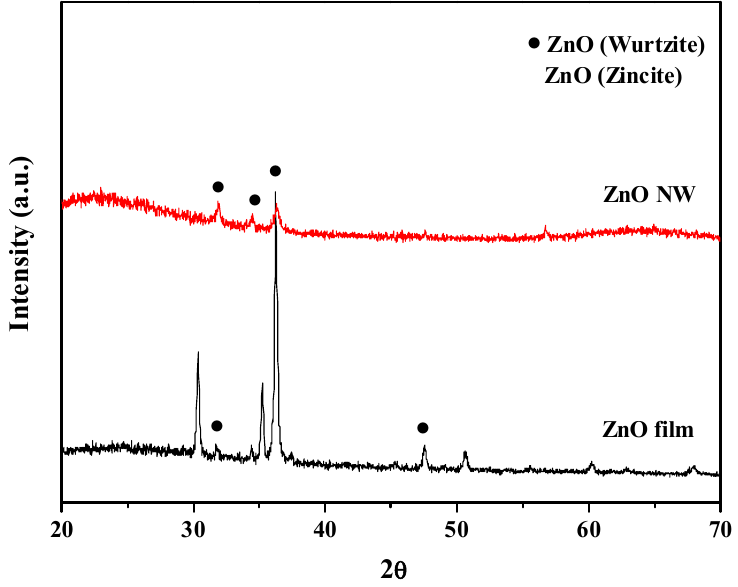
Figure 6. X-ray diffraction (XRD) results of the ZnO film and the ZnO nanowires.